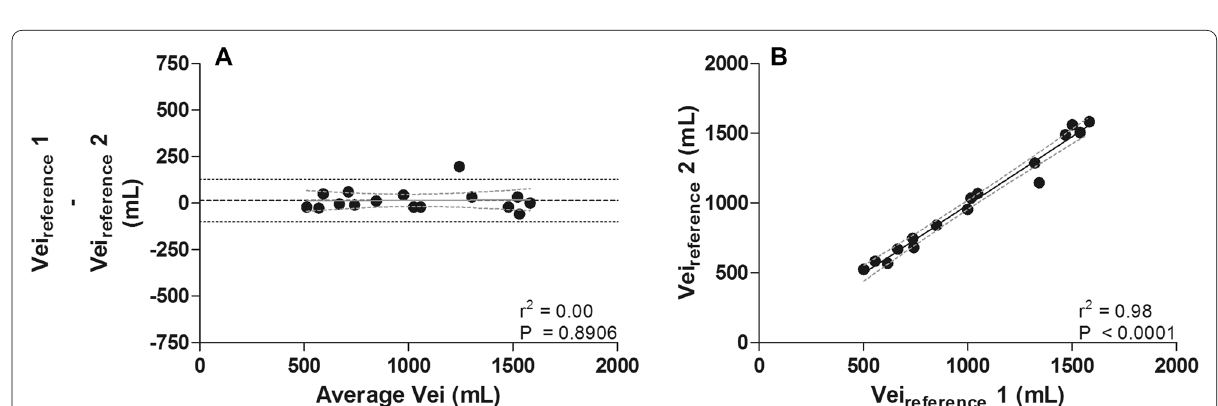
Fig. 3 Dynamic pulmonary hyperinflation did not change during the study protocol: there was a low bias with high agreement ( A ) and high correlation between the two measurements of Vei reference ( B ) (solid line with dashed 95% CI